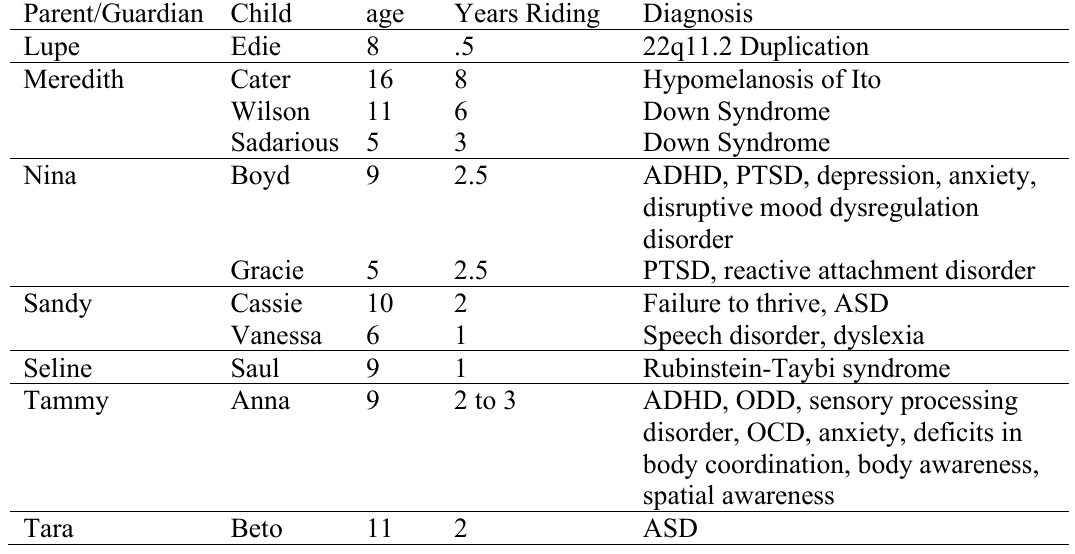
Table 1 . Participants and their children (pseudonym names) who ride horses.